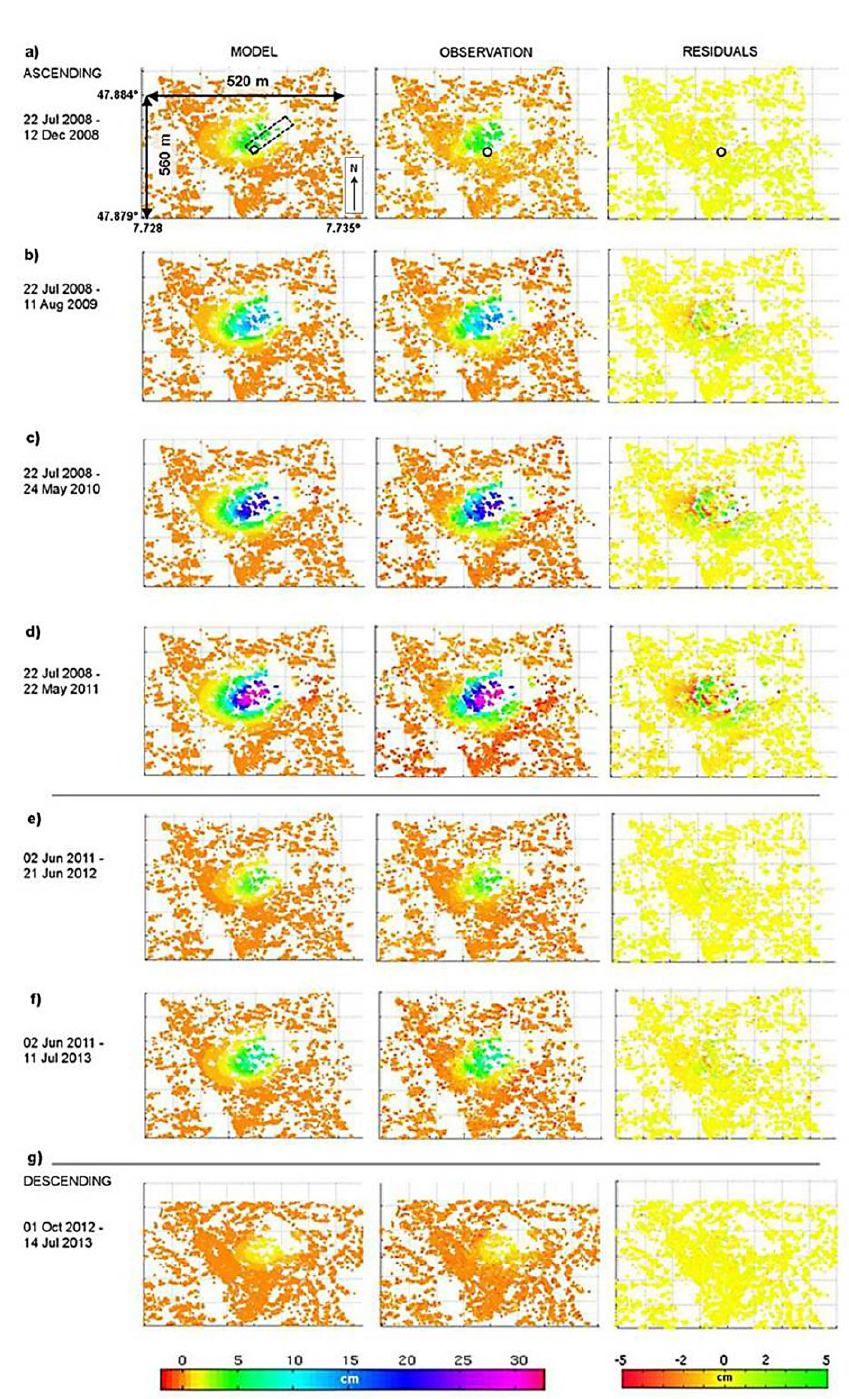
Figure 4. Modeled surface displacement (first column) due to a rectangular finite dislocation source for different periods of the ascending data of [3] in ( a )–( d ) and of those processed in this study in ( e )–( f ). In 4( g ) the descending outcome is shown. Corresponding source characteristics are listed in Table 2. Observed line of sight (LOS) cumulative displacements and residuals (difference between observation and model prediction) are shown in column two and three, respectively. The outline of the estimated rectangular source is shown by a dashed contour exemplarily for the corresponding period in 4( a ), left column, and the black circle indicates the drilling field